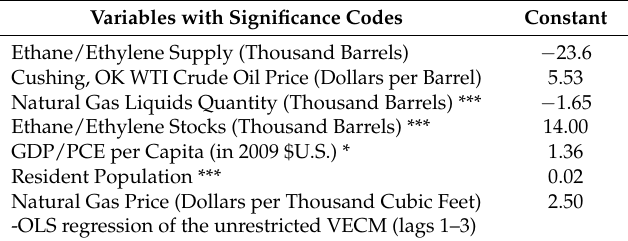
Table 3. Matrix of Deterministic Coefficients for the Base VECM.